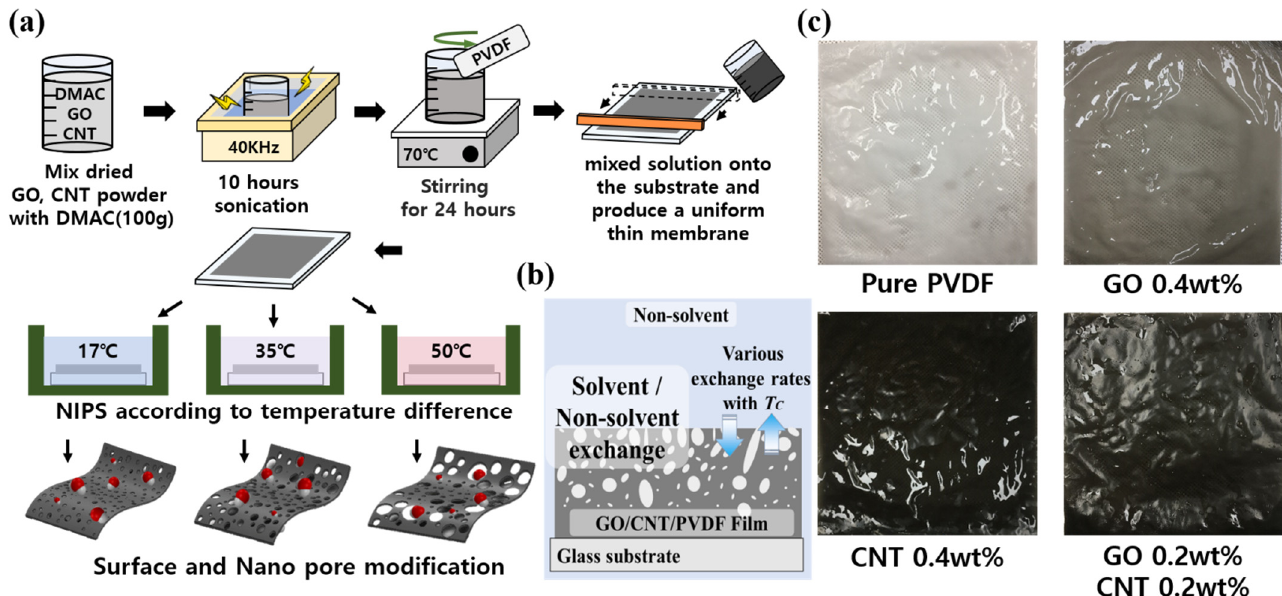
Figure 1. ( a ) The fabrication of GO and MWCNT-based PVDF membranes according to the content ratio of carbon materials and the change in coagulation temperature. ( b ) Conceptual diagram of non-solvent-induced phase separation. ( c ) Optical images of fabricated PVDF membranes with 0.4 wt% GO, 0.4 wt% CNTs and 0.2 wt% GO + 0.2 wt% CNTs, respec- tively.